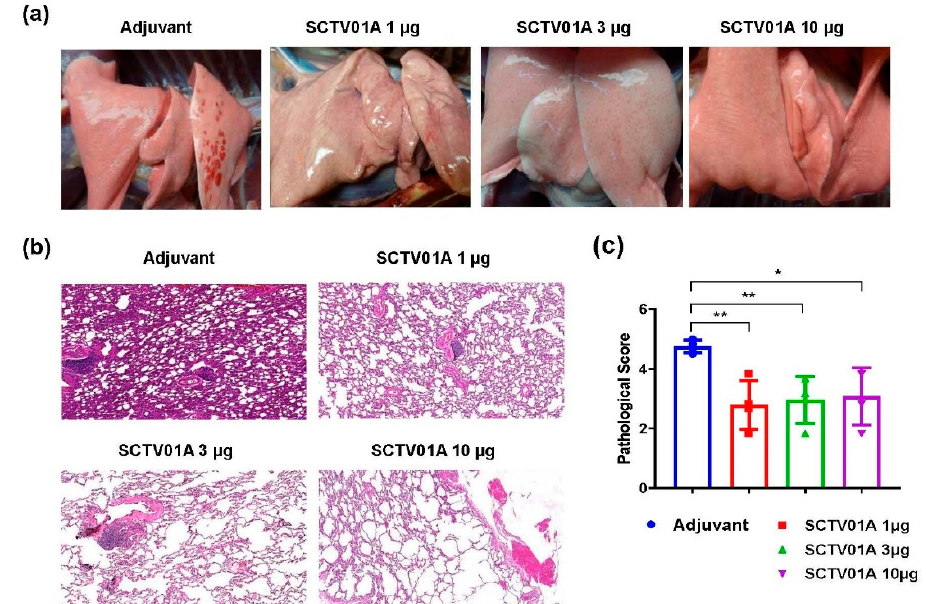
Figure 4. Lung pathology is reduced in SCTV01A-vaccinated rhesus macaques after SARS-CoV-2 challenge. ( a ) Representative gross anatomy of lung tissue of adjuvant, SCTV01A vaccines animals. ( b ) Representative histopathological staining of the lungs from macaques at 7 dpi. ( c ) Statistical pathological scores of lung in different vaccination groups. Statistical analyses were performed using unpaired two-tailed tests. * p < 0.05, ** p < 0.001.